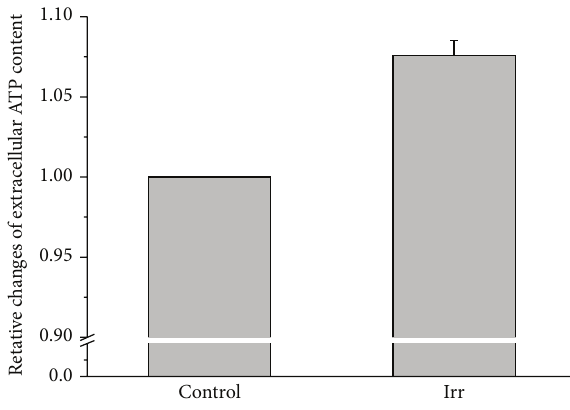
Figure 5: Extracellular ATP content of rat peritoneal MCs in response to 657 nm, 18mW/cm 2 , and 21J/cm 2 laser irradiation. Changes of extracellular ATP content of rat peritoneal MCs induced by laser irradiation averaged for respective irradiation times of all samples. The data represent averages ± SEM from 𝑛 = 12 - 13 .